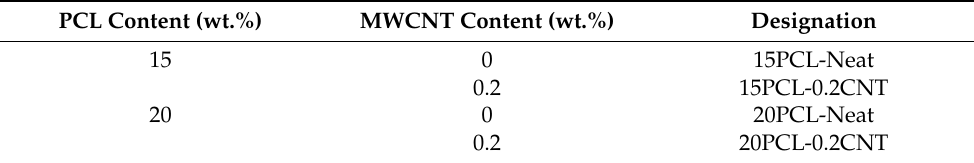
Table 2. Nomenclature used for the different manufactured multiscale composites. PCL Content (wt.%)